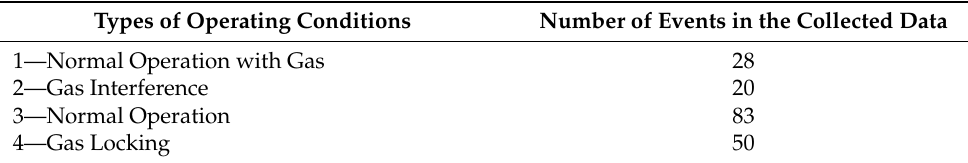
Table 1. Distribution of operating